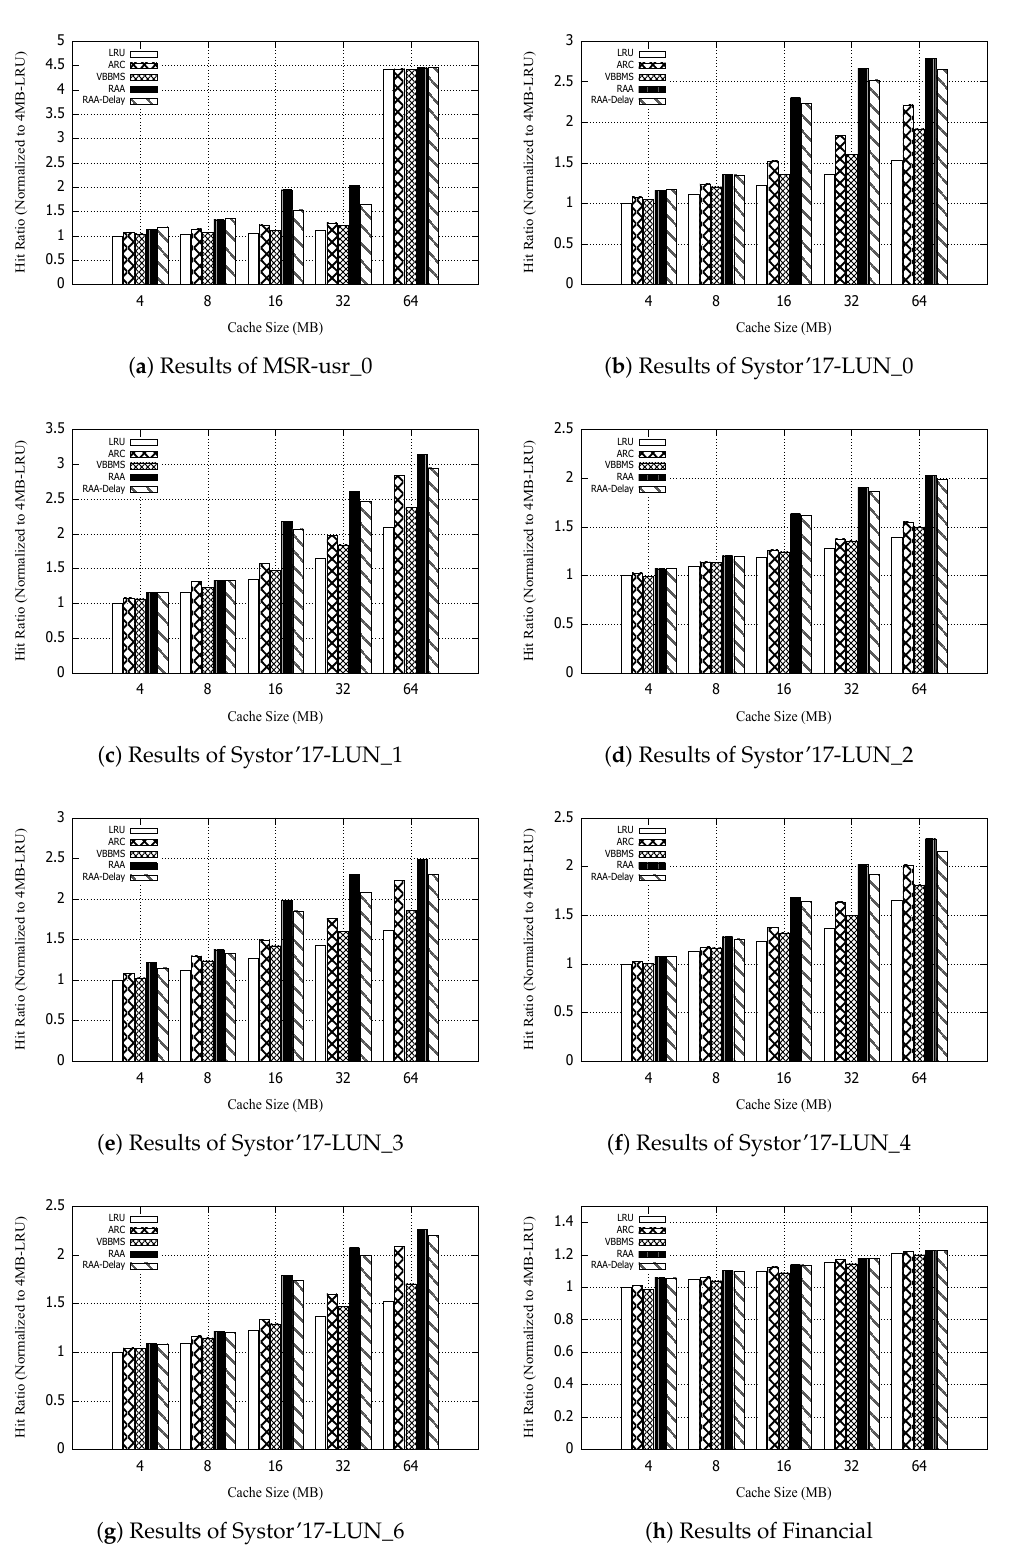
Figure 10. Improvement of the average hit